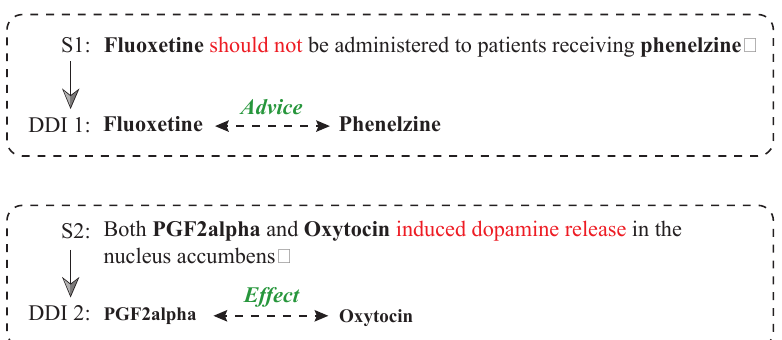
Figure 1. Two examples illustrating DDI extraction from drug-related text